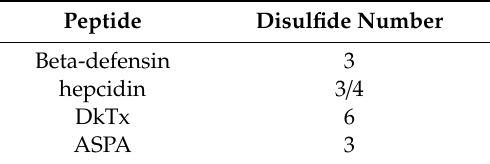
Table 6. Peptides used in the current study.